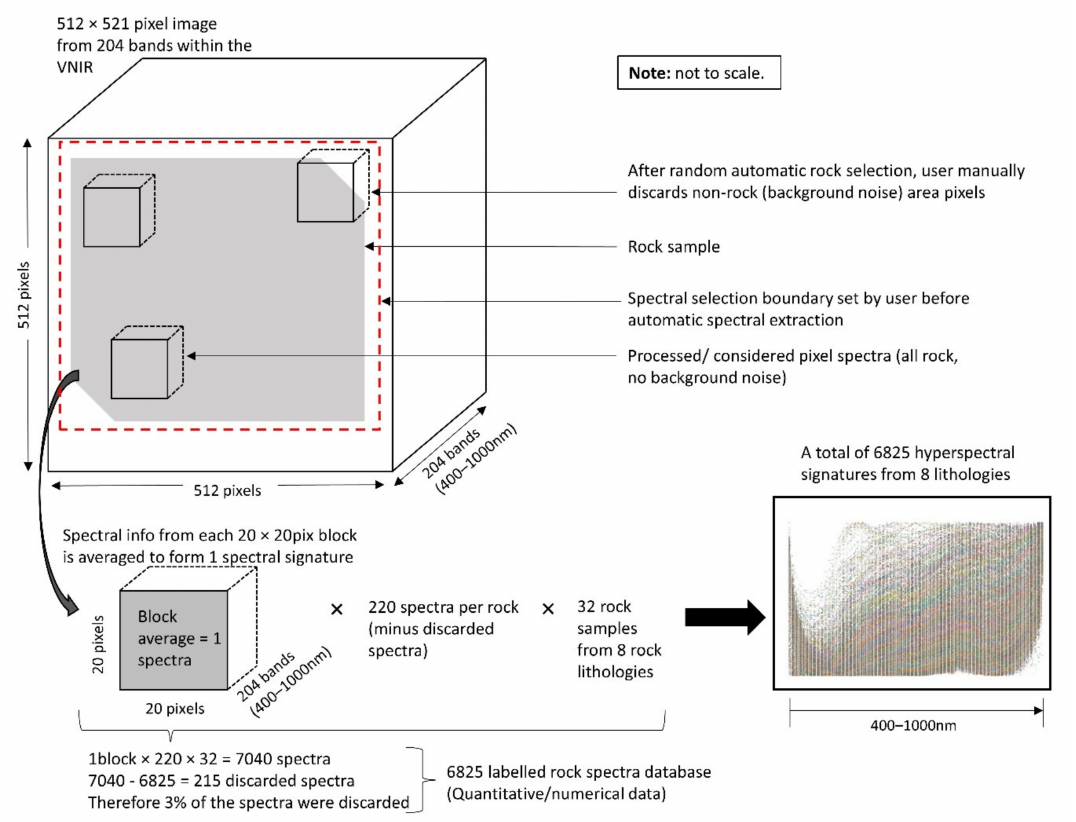
Figure 4. Automatic random extraction of rock pixel spectra captured via a Specim IQ camera that acquires 512 × 512 pixel images from 204 bands within the Visible-Near-Infrared-Range. Extracted spectra are used to build a rock hyperspectral